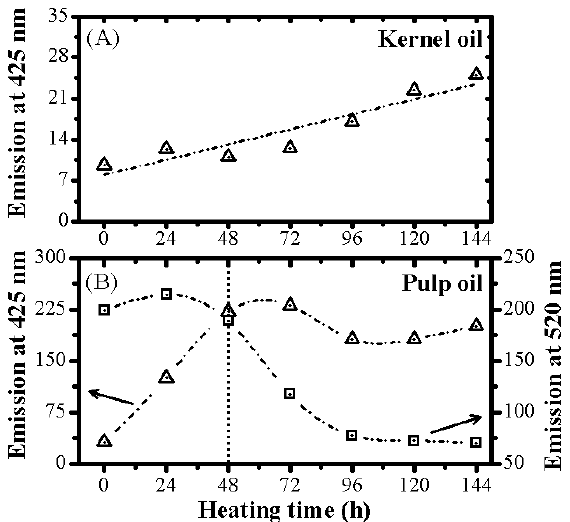
Figure 8. Fluorescence intensity of the degradation product at 425 nm, when excited at 330 nm, as a function of the heating time for ( A ) kernel oil and ( B ) pulp oil. The right axis in (B) presents the carotenoids emission at 520 nm when excited at 345 nm.